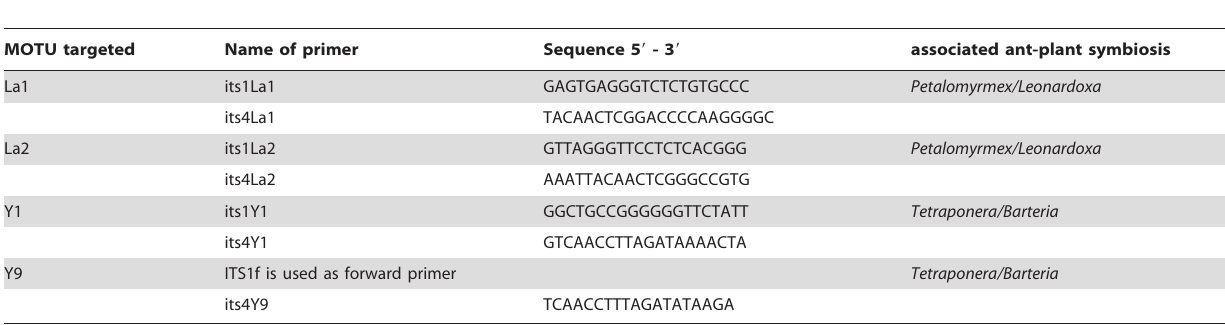
Table 1. Sequences of primers developed in this study to amplify specifically the ITS region of fungal Molecular Operational Taxonomic Units (MOTU) detected in two focal ant-plant